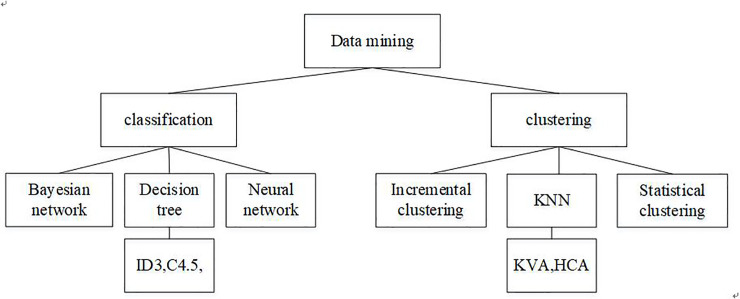
Ontology structure of data mining.